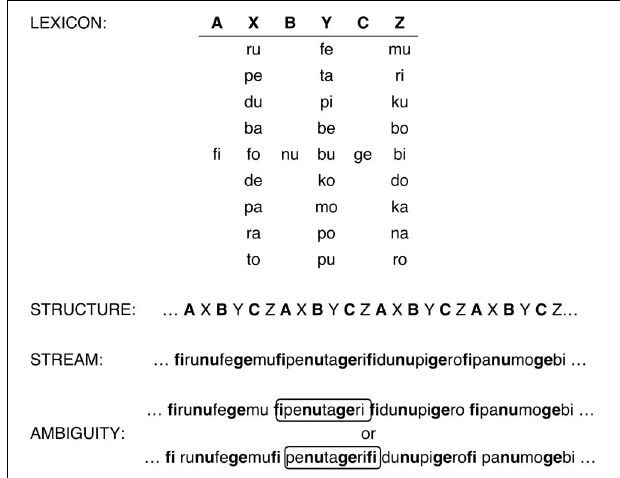
FIGURE 2 | The material used in the experiment. The lexicon contains the syllables used in the three frequent and three infrequent categories. The structure shows how the six-syllable-long basic unit is concatenated to create the familiarization stream. The structural ambiguity is shown by the two possible parses of the stream. The upper tier illustrates the FI parse, the lower tier shows the IF one. The encircled chunks are examples of FI and IF test items,